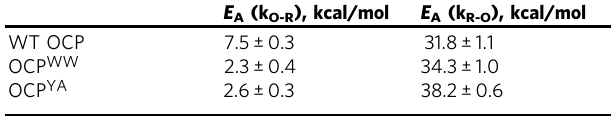
Average power of actinic LED light was set to 200mW in all experiments. Experiments were conducted in a range of temperatures from 25 to 40°C. Values are given as means±S.D. and resulted from three